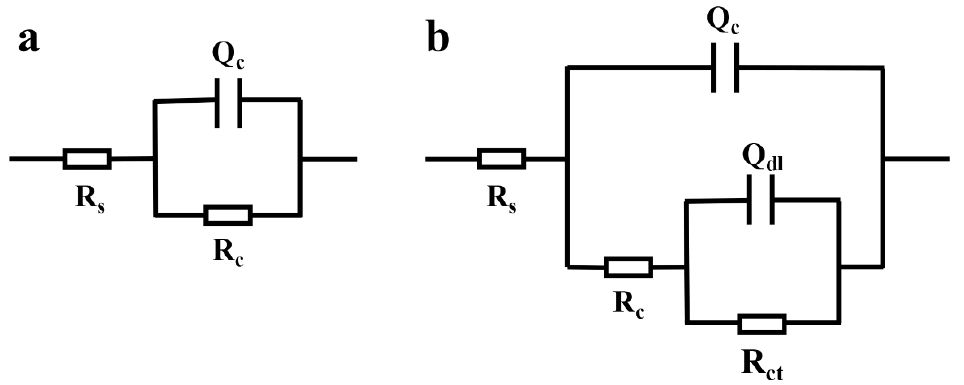
Figure 6. Equivalent circuit models used to fit the EIS curves, ( a ) one time constant, ( b ) two time constants.